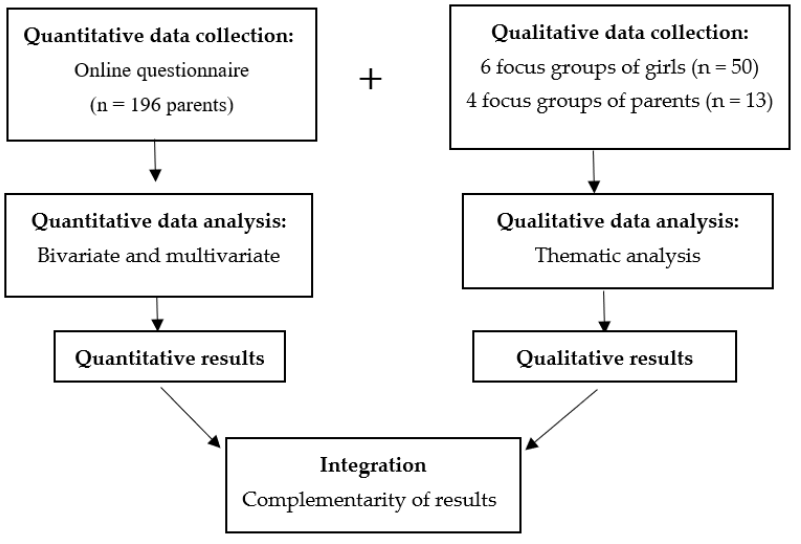
Figure 1. Convergent mixed-methods